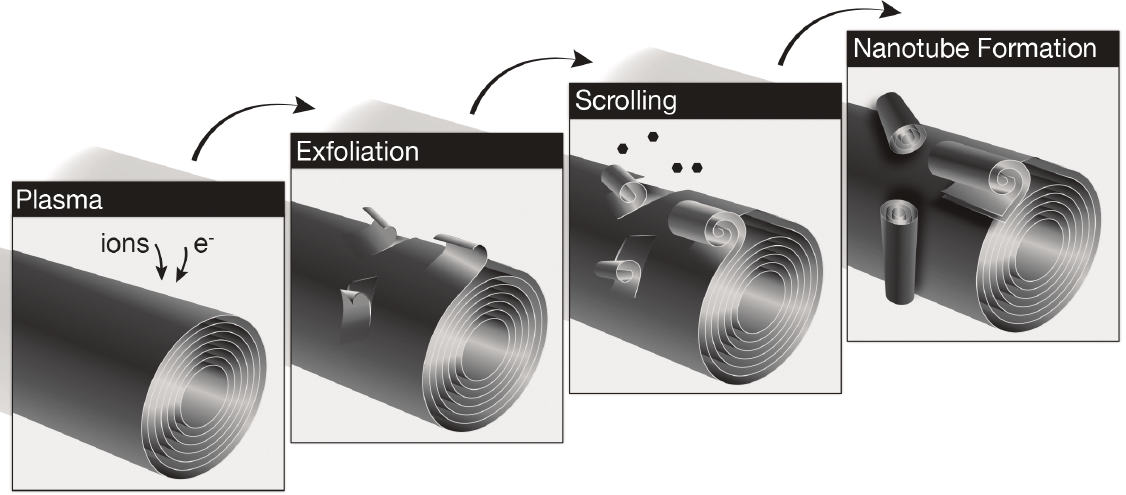
Figure 8. Schematics of the proposed growth mechanism of the daughter nanotubes by plasma treatment of the multiwall mother